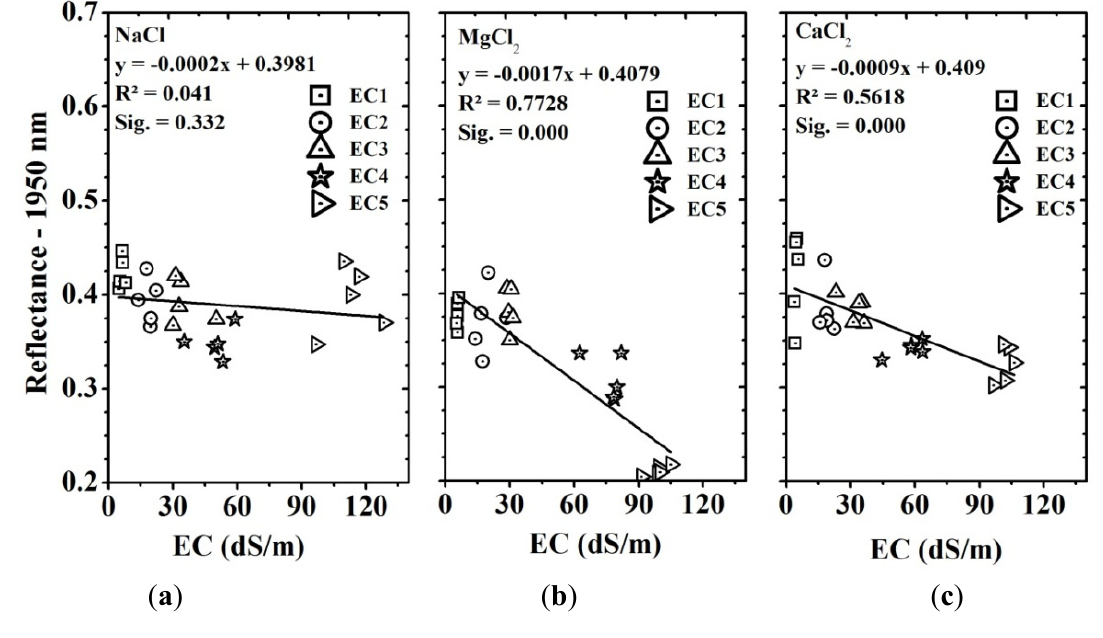
Figure 9. Relationship between the reflectance at 1950 nm and the electrical